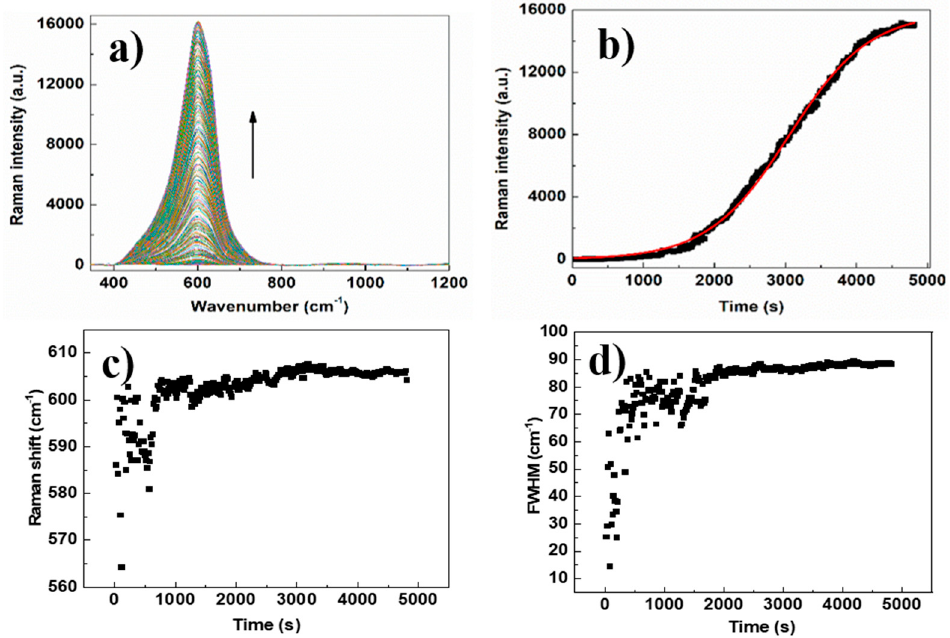
Figure 9. ( a ) Time-dependent Raman spectrum of Cr (III) + EDTA in the presence of Oxa-AgNPs at pH = 9.6. ( b ) Plotting and fitting the maximum of Raman intensity versus time by using Prout–Tompkins equation. k = 0.1 min − 1 , Adj. R-squared 0.998. ( c ) Raman shift versus time of Cr (III) + EDTA in the presence of Oxa-AgNPs at pH 9.6. ( d ) FWHM variation of the Raman peak versus time of Cr (III) + EDTA in the presence of Oxa-AgNPs at pH 9.6.